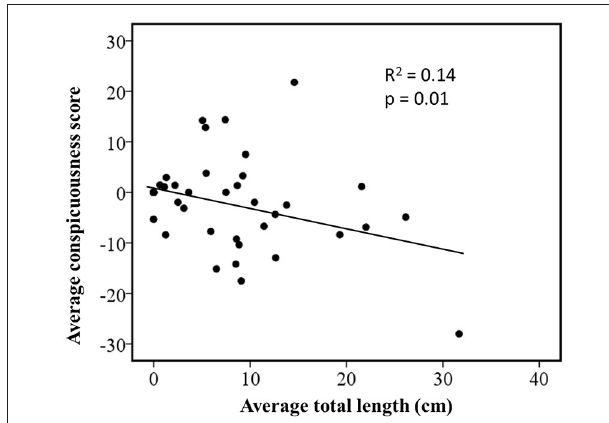
FIGURE 2 | Relationship between coloration and body size in Plethodon salamanders estimated by phylogenetically independent contrasts using a gradual model of evolutionary change. The figure shows standardized contrasts for average total length against standardized contrasts for average ratings of conspicuousness.